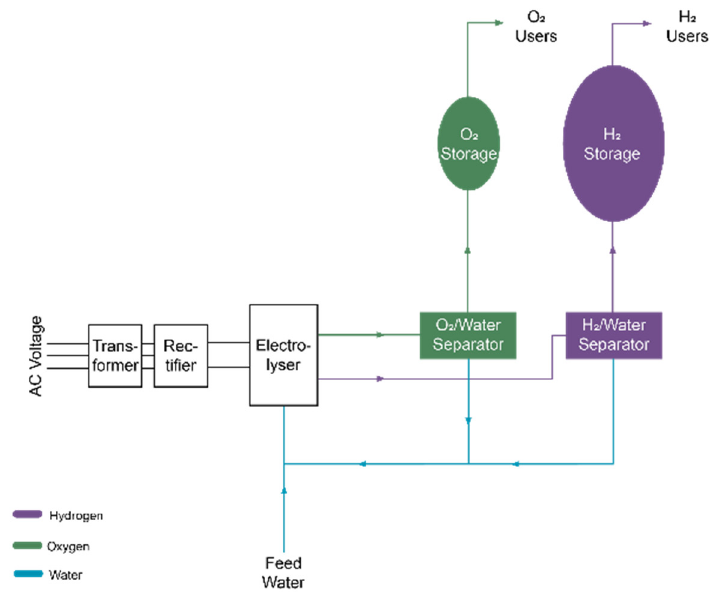
Figure 2. Basic building blocks of a P2G system.